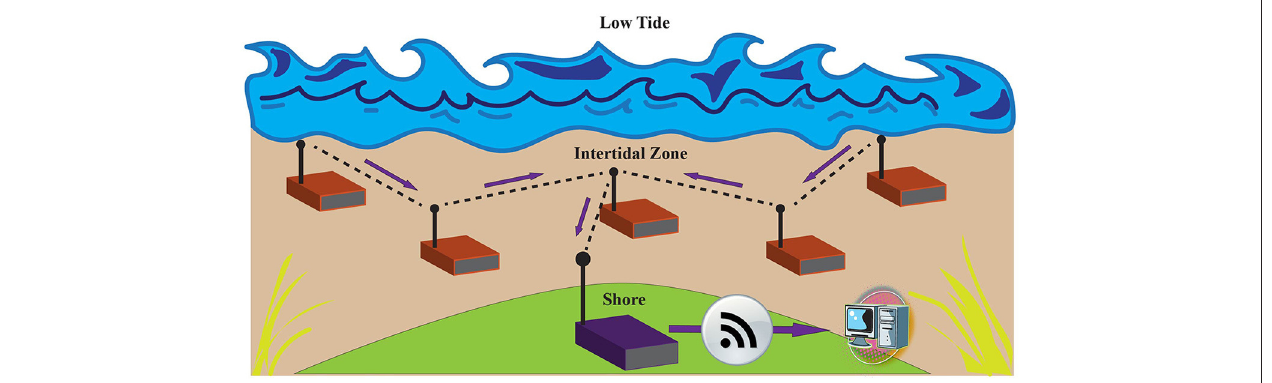
FIGURE 5 | Diagram of a mesh Intertidal Wireless Sensor Network (IT-WSN) that uses PIDO (Predictive Delay Optimization) for more frequent and effective intertidal data transmission as described in Zhou et al. (2018). Environmental data are collected by the sensor nodes (red) where they is then transmitted via links (dashed lines) to other nodes (Freq. = 915 MHz) using the most efficient routing path during low tide. Data are then transmitted to a land-based sink node (purple) before they are offloaded to a computer.